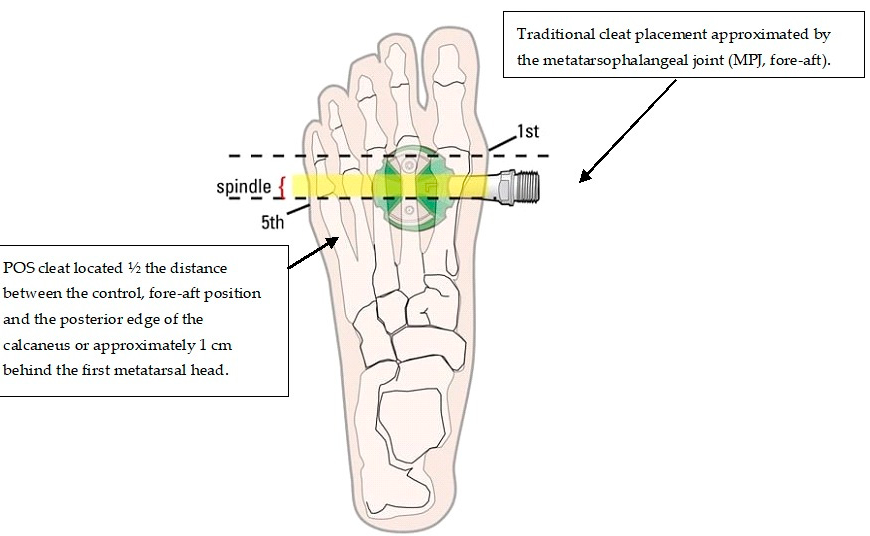
Figure 1. Representation of two different cleat locations (not to scale). Retrieved from bikefit.com (accessed on 31 August 2021).